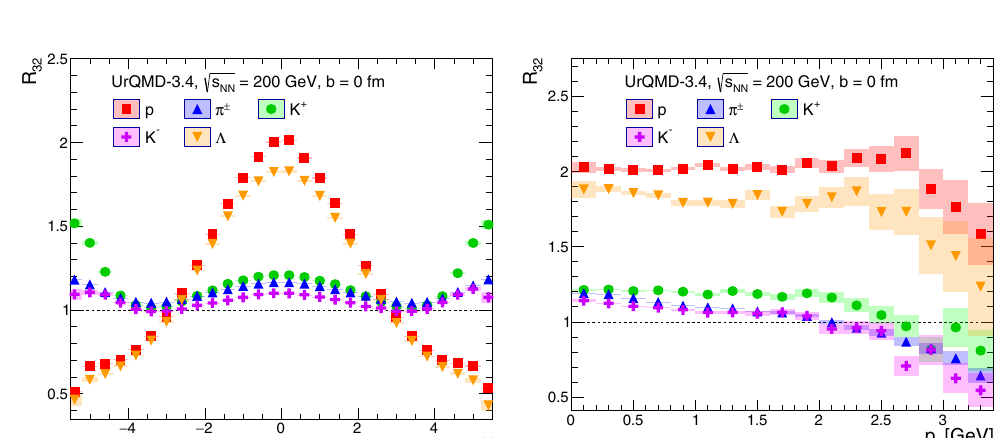
expected for the most central and d y y < 0 . | |